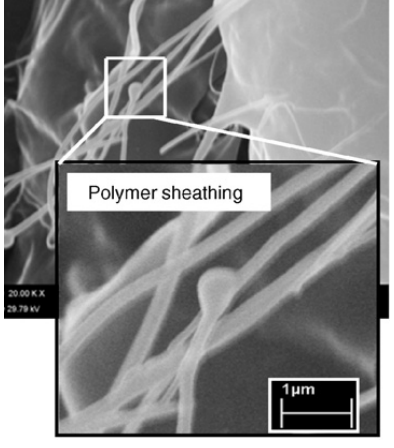
Figure 6. SEM micrograph of ‘‘polymer sheathing” phenomena of the fractures surface of PP/MWCNTs nanocomposite with 1 wt % of MWCNTs. Reproduced with permission from ref.